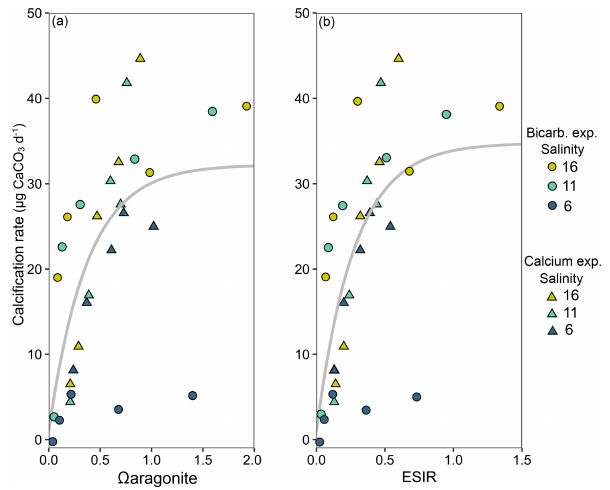
Figure 6. Mean calcification rates in each salinity treat- ment from both laboratory experiments ([HCO − ] – circles and 3 [Ca 2 + ] – triangles) across calculated (cid:127) aragonite (a) and ESIR ([Ca 2 + ][HCO − ] / [H + ]) (b) . Non-linear negative exponential de- 3 cay models are graphically presented across both laboratory exper- iments, and vertical dotted lines represent the theoretical saturation thresholds, below which calcification rates are severely impeded ( (cid:127) aragonite = 1, ESIR = 0.7).